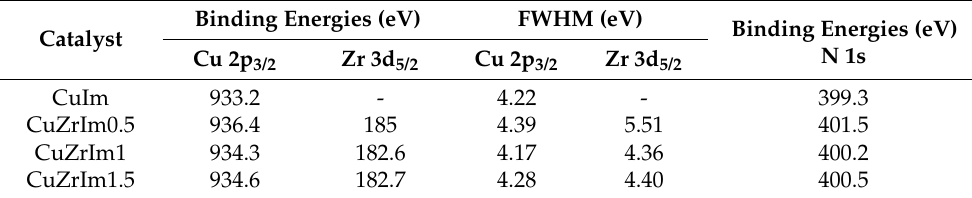
Table 1. XPS data of CuIm and CuZrIm catalysts with different Zr